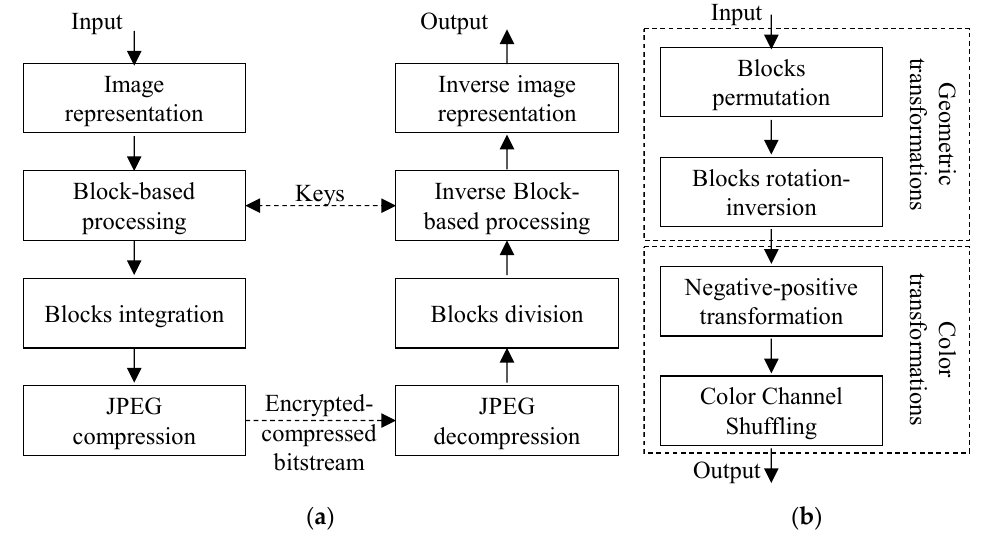
Figure 1. Illustration of block-based perceptual encryption algorithm. ( a ) The main steps of com- pressible perceptual encryption algorithm. ( b ) The geometric and color transformations of percep- tual encryption algorithms.